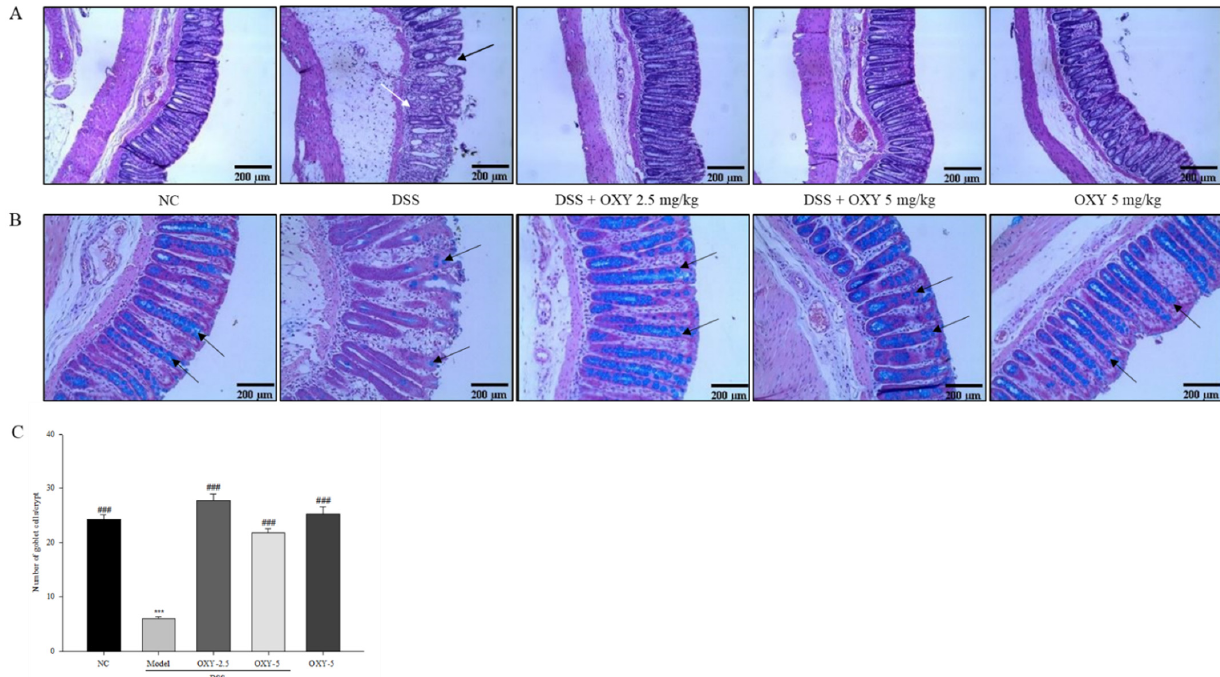
Figure 3. Effect of OXY on histopathological changes in the distal colon ( n = 8/group). The middle part of distal colons was sectioned and stained with hematoxylin and eosin (H&E) ( A ), infiltrated inflammatory cells (white arrow) and damaged crypt structure (black arrow) as well as with Alcian blue ( B ), goblet cell (black arrow). Goblet cells within a crypt were counted ( C ). NC, normal control group; model, DSS-induced colitis model group; DSS + OXY-2.5, DSS-induced colitis rats treated with OXY (2.5 mg/kg) group; DSS + OXY-5, DSS-induced colitis rats treated with OXY (5 mg/kg) group; OXY-5, rats treated with OXY (5 mg/kg) alone group. The values are expressed as mean ± SEM. Significant differences among groups were evaluated via ANOVA with Tukey’s post hoc HSD. *** p < 0.001 compared with the NC group; ### p < 0.001 compared with the model group.